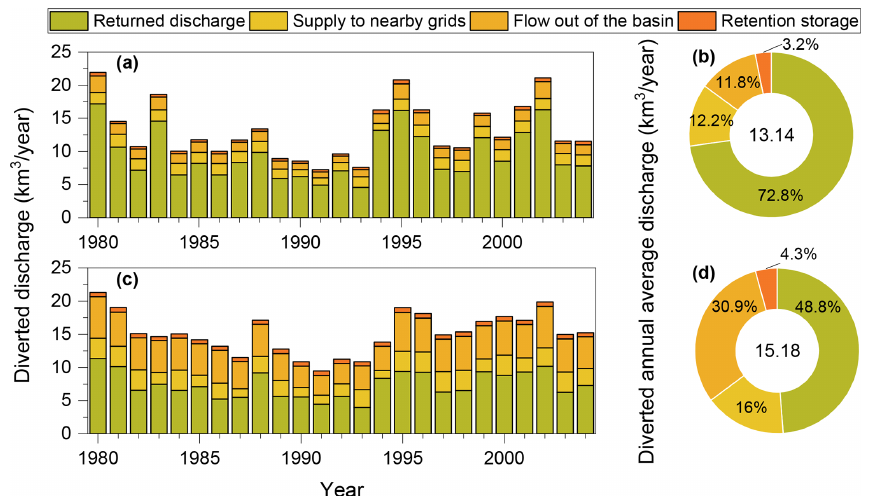
Figure 6. Amount of flow transferred from the canal systems to each of the components (from 1980–2004) and their percentage contribution to the annual canal flow averaged over 1980 to 2004 under the regionalized scheme (a, b) and generalized scheme (c, d) .